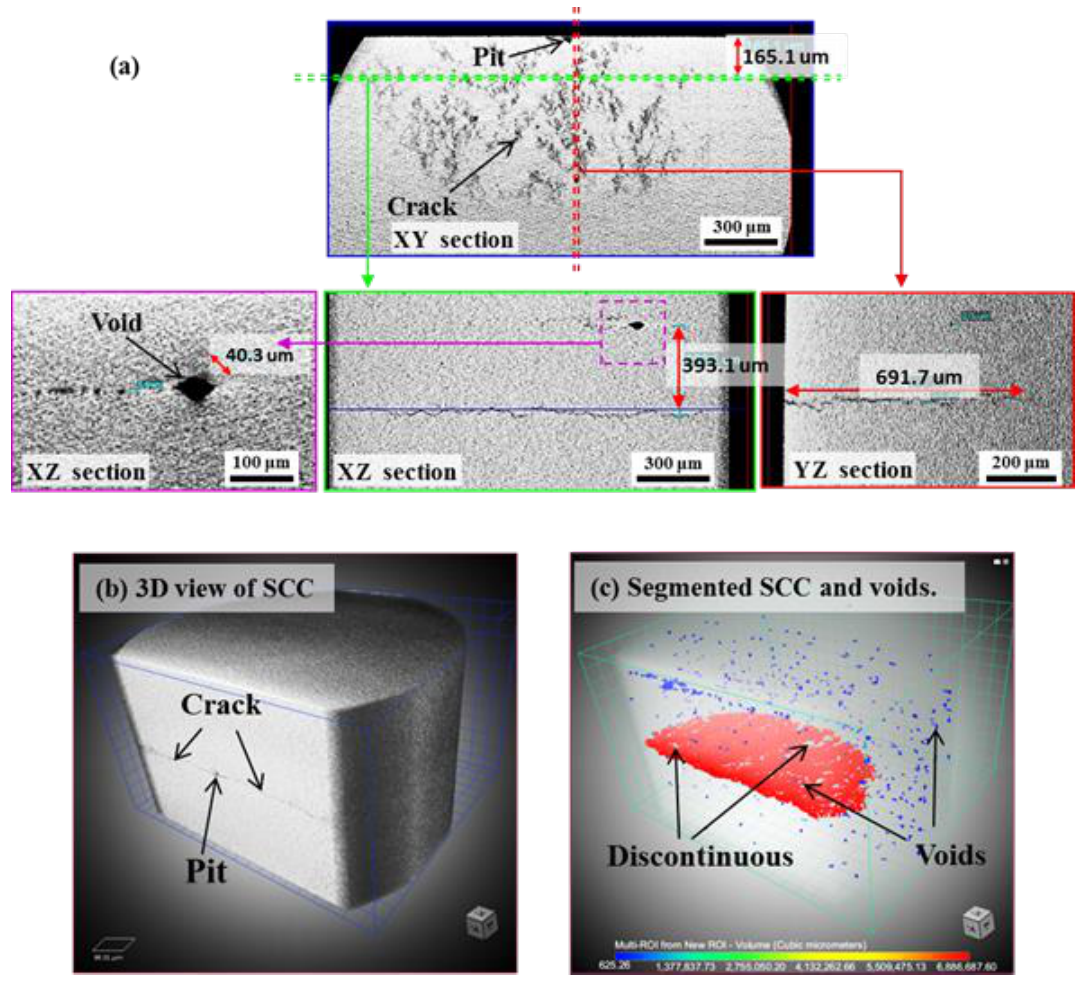
Figure 9. X-ray computed tomography (XCT) data of SCC of specimen B: ( a ) Virtual slices in different sections; ( b ) 3D tomogram; ( c ) Segmented crack and voids with transparent volume of materials. Here, the color is based on the volume. Online version in color.